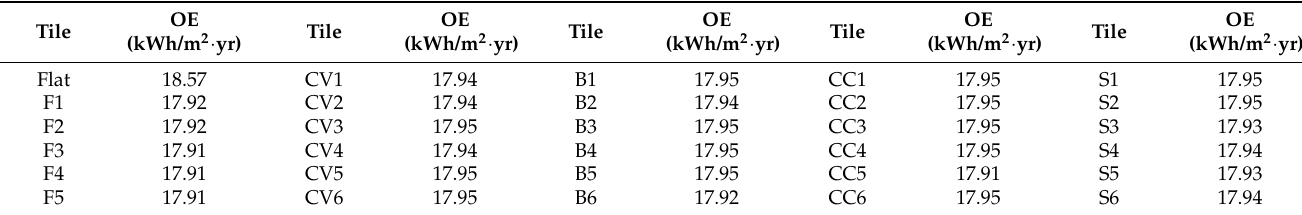
Table 6. Residential-type building: total heating and cooling energy